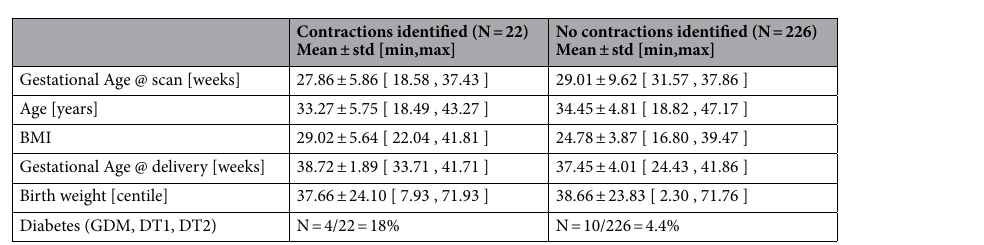
Figure 2. Identified significant changes associated with contractile activity in the uterus are shown in schemata and in coronal or reformatted sagittal views of the MEGE scans. A schemata without signs of contractions (left) is followed by four different identified signs on T2/T2* weighted images ( a ) thickening of the uterine wall underneath the placenta, ( b ) hypointense (on T2) lines in the placental parenchyma, ( c ) hypointense (on T2) rim next to the chorionic plate and ( d ) thickening of the uterine wall in other areas of the uterine wall, not underlying the placenta.The red bars and arrows indicate the changes, in ( a ) the thickening underneath the placenta, in ( b ) the vessel like hypointense bands in the placenta, in ( c ) the hypointense band on the chorionic surface and in ( d ) the thickening of the myometrium distant to the placenta.